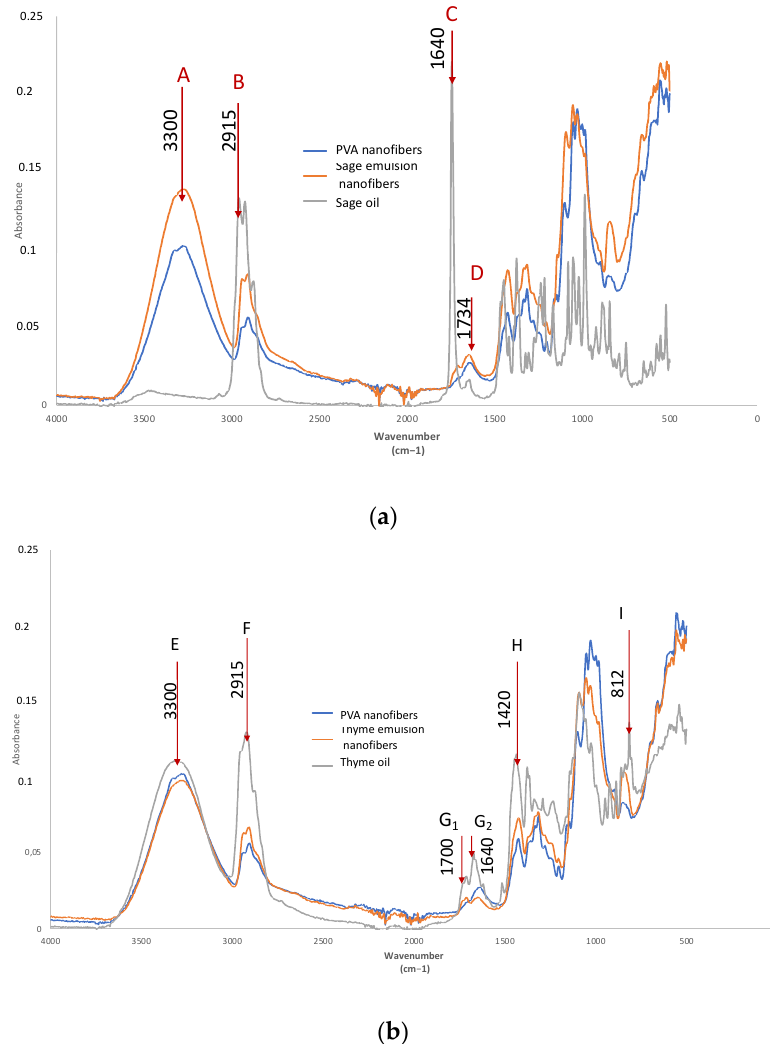
Figure 8. Infrared spectrum of nanofibers. ( a ) Sage essential oil; blue line: PVA nanofibers; orange line: sage emulsion nanofibers; grey line: sage oil. ( b ) Thyme essential oil; blue line: PVA nanofibers; orange line: thyme emulsion nanofibers; grey line: thyme oil. Table 6. Band intensity of FTIR spectra of PVA, sage, and electrospun PVA − sage nanofiber